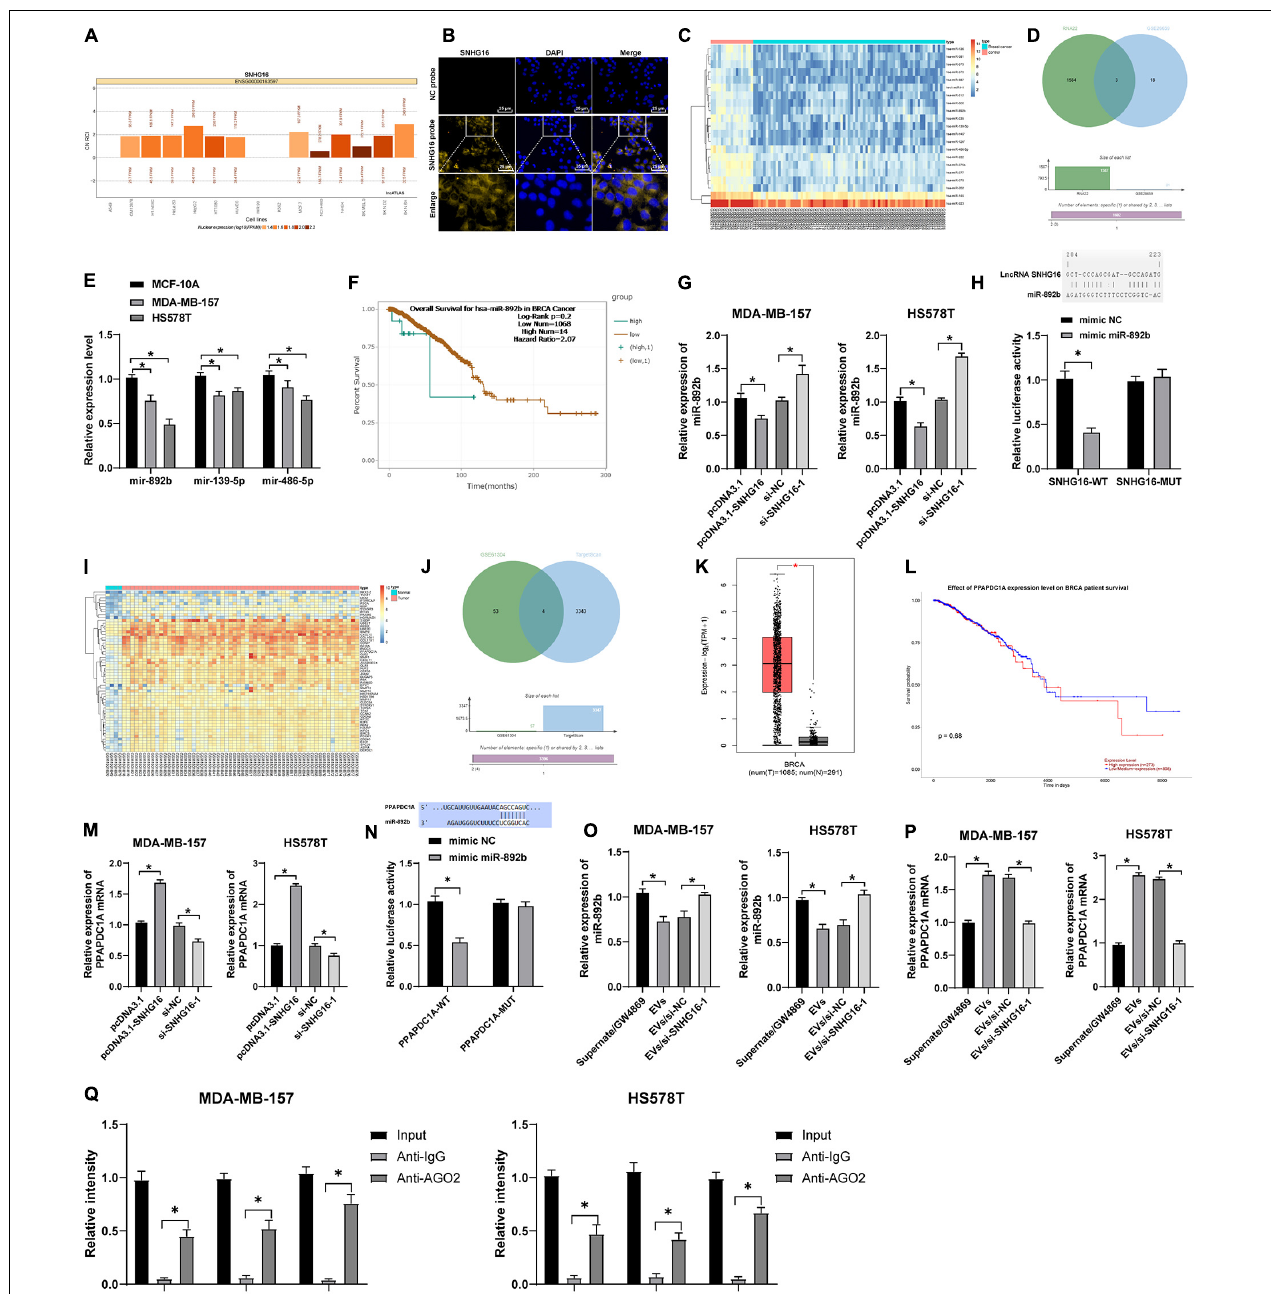
FIGURE 5 | LncRNA SNHG16 sponged miR-892b to regulate PPAPDC1A. (A) SNHG16 was mainly located in the cytoplasm through LncATLAS prediction. (B) RNA FISH confirmed that SNHG16 was distributed in the cytoplasm of MDA-MB-157. (C) The heat map of downregulated miRNAs in BC in the GSE26659, the abscissa is the sample number and the ordinate is the miRNA name; the histogram at the top right is the color scale. (D) The intersection between the prediction results of RNA22 database for the downstream miRNAs of SNHG16 and the downregulated miRNAs in GSE26659; the two circles in the panel show the prediction results of RNA22 and the results of microarray analysis, and the middle part shows the intersection of the two set of data. (E) The expressions of miR-139-5p, miR-892b, and miR-486-5p in MDA-MB-157, HS578T, and MCF-10A cells were detected using RT-qPCR. (F) Kaplan–Meier curve of miR-892b in BC patients from ENCORI pancancer database. (G) MDA-MB-157 and HS578T cells were transfected with pcDNA3.1-SNHG16 and si-SNHG16, and the expression of miR-892b was detected using RT-qPCR. (H) The binding relationship between SNHG16 and miR-892b was verified using dual-luciferase gene reporter assay. (I) The heat map of downregulated genes in BC in the GSE61304. (J) Intersection of miR-892b target genes predicted by TargetScan and upregulated genes in GSE61304. (K) Differential expression of PPAPDC1A in BC samples and normal samples collected by TCGA and GTEx database. (L) Kaplan–Meier curve of PPAPDC1A